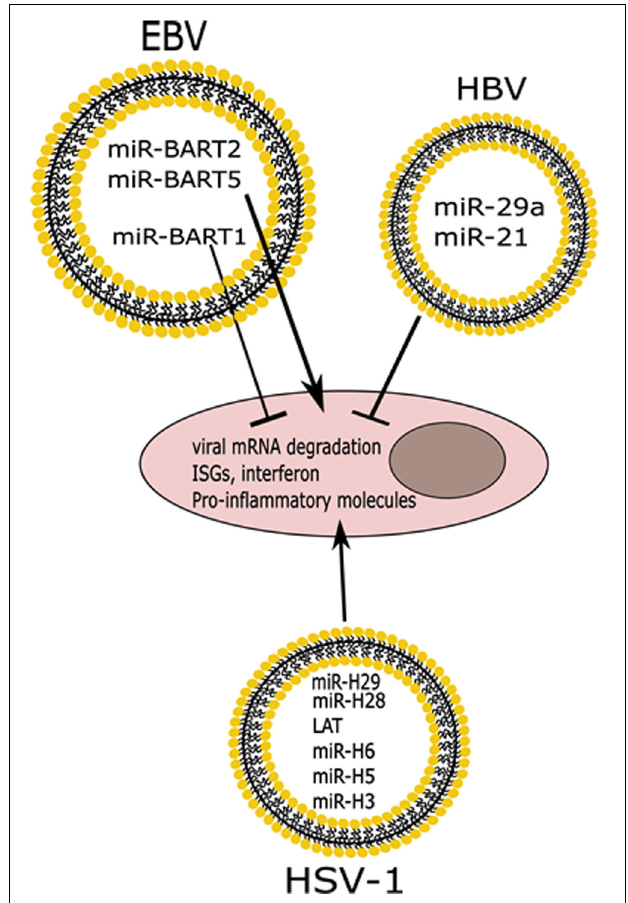
FIGURE 4 | Differential effects of miRNAs released in EVs from infected cells. Infection with HSV-1 or EBV induces the release of vesicles containing viral miRNAs that cause degradation of viral mRNAs, while also inducing the expression of ISGs and pro-inflammatory molecules. EBV also expresses a miRNA that functions to block innate immune responses. HBV infection induces the release of immunomodulatory miRNAs that also suppress the innate immune